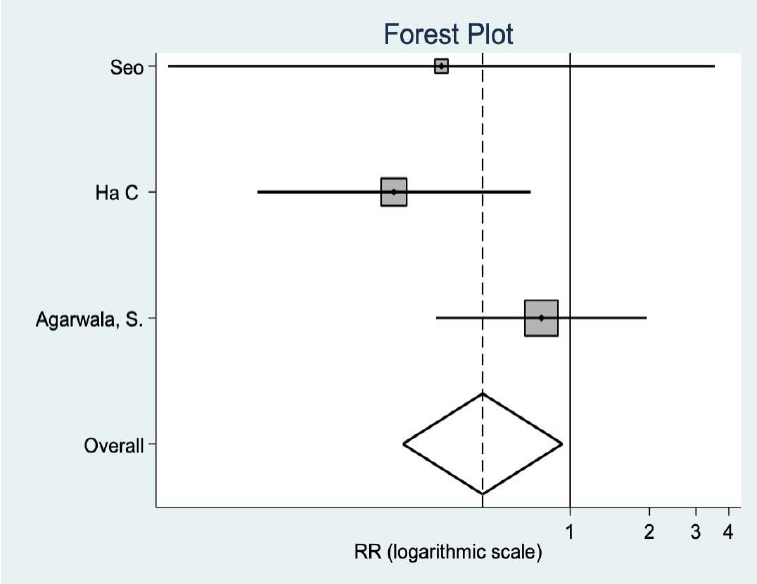
Figure 8. Anterior knee pain data.